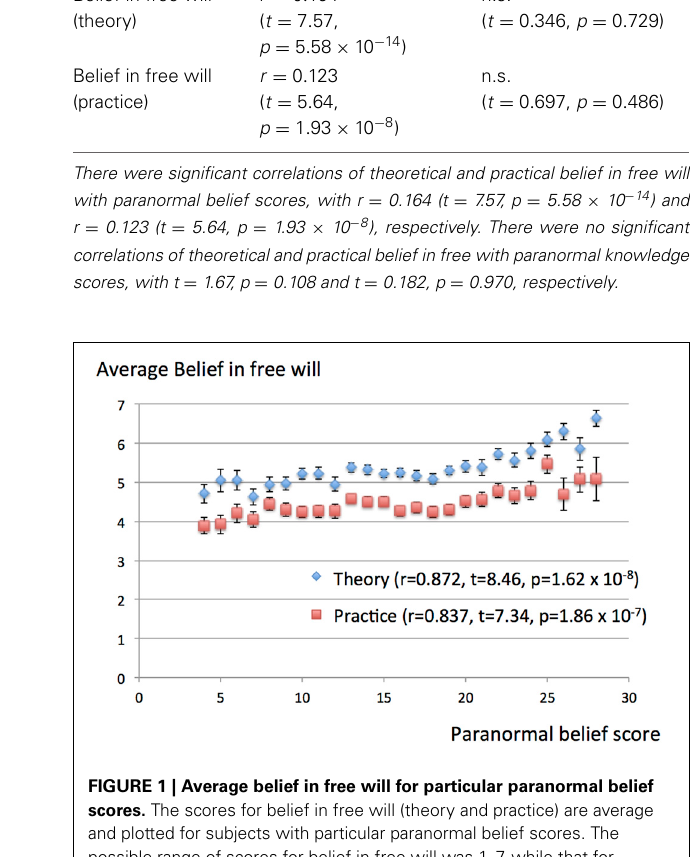
significant correlations between paranormal knowledge scores